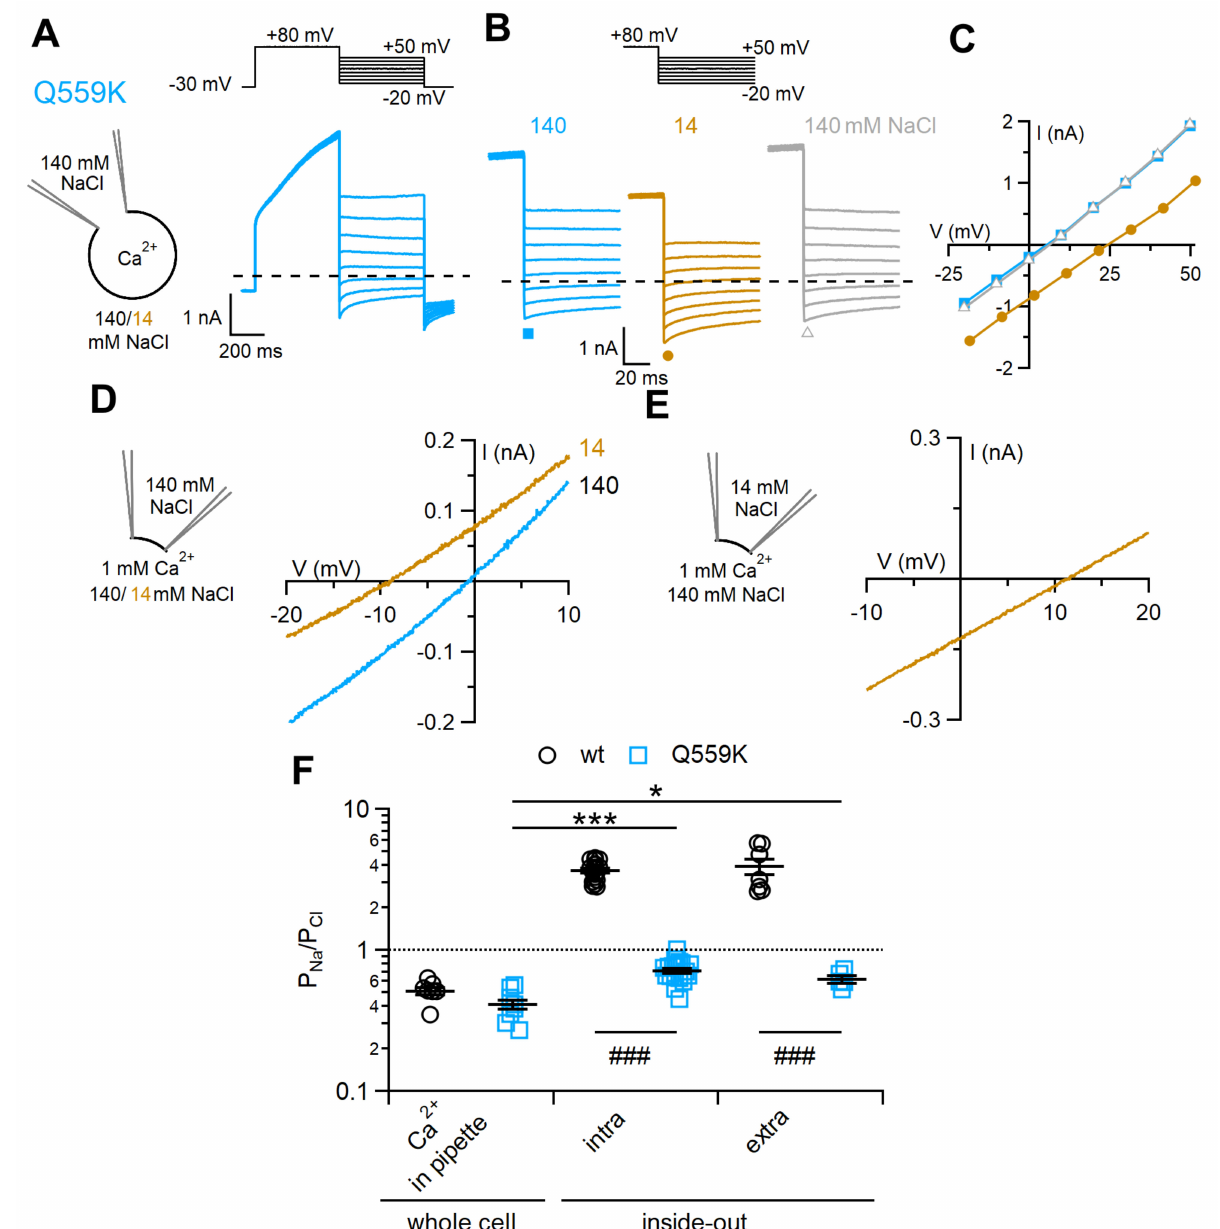
Figure 6. Q559K ion permeability ratio P Na /P Cl depends on the recording configuration. ( A , B ) Representative whole-cell voltage-clamp recordings obtained from TMEM16F Q559K mutant-transfected cells with intracellular solution containing 300 µ M Ca 2+ . Voltage protocols are shown at the top of the panels. ( B ) A cell was exposed to a control solution containing 140 mM NaCl, then to 14 mM NaCl, followed by wash out with 140 mM NaCl. ( C ) IV relations measured from tail currents of the cell shown on the left with 140 mM NaCl (squares), 14 mM NaCl (circles) and after wash out (triangles). ( D , E ) Inside-out patches expressing TMEM16F were exposed to the indicated NaCl concentrations, and the IV relations were determined by voltage ramps from +100 to − 80 mV. Only the regions around the reversal potentials are shown. Currents were activated by 1 mM CaCl 2 and leakage currents measured in 0 Ca 2+ were subtracted. The pipette solution contained 140 mM NaCl ( C ) or 14 mM NaCl ( D ). ( F ) Comparison of P Na /P Cl in different recording conditions for Q559K and wt (n = 5–19; *** p < 0.001, * p < 0.05 Tukey test after ANOVA, F = 18.271, p = 8.36 × 10 − 6 ; ### p < 0.001, unpaired t